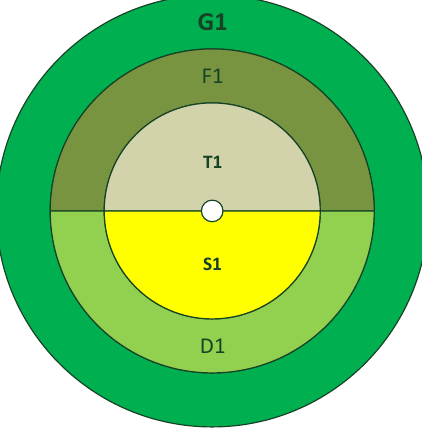
Figure 5. Distribution of the calculated or measured impedances according to the relevant performance criteria for Zone 1.